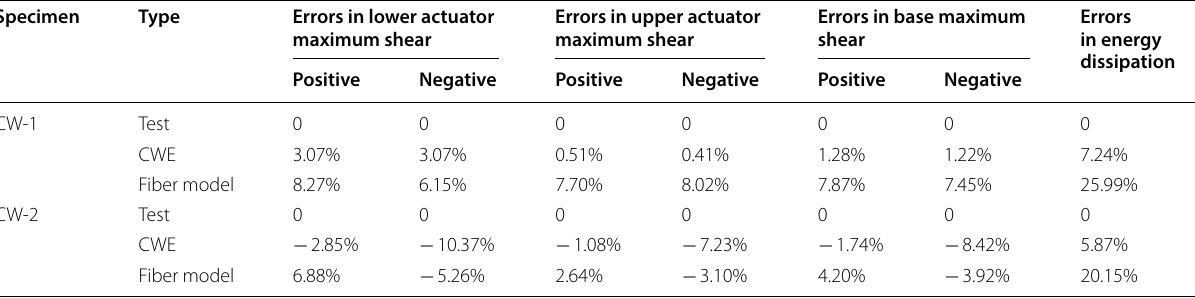
Table 6 The error comparisons of the selected indicators. Specimen Type Errors in lower actuator